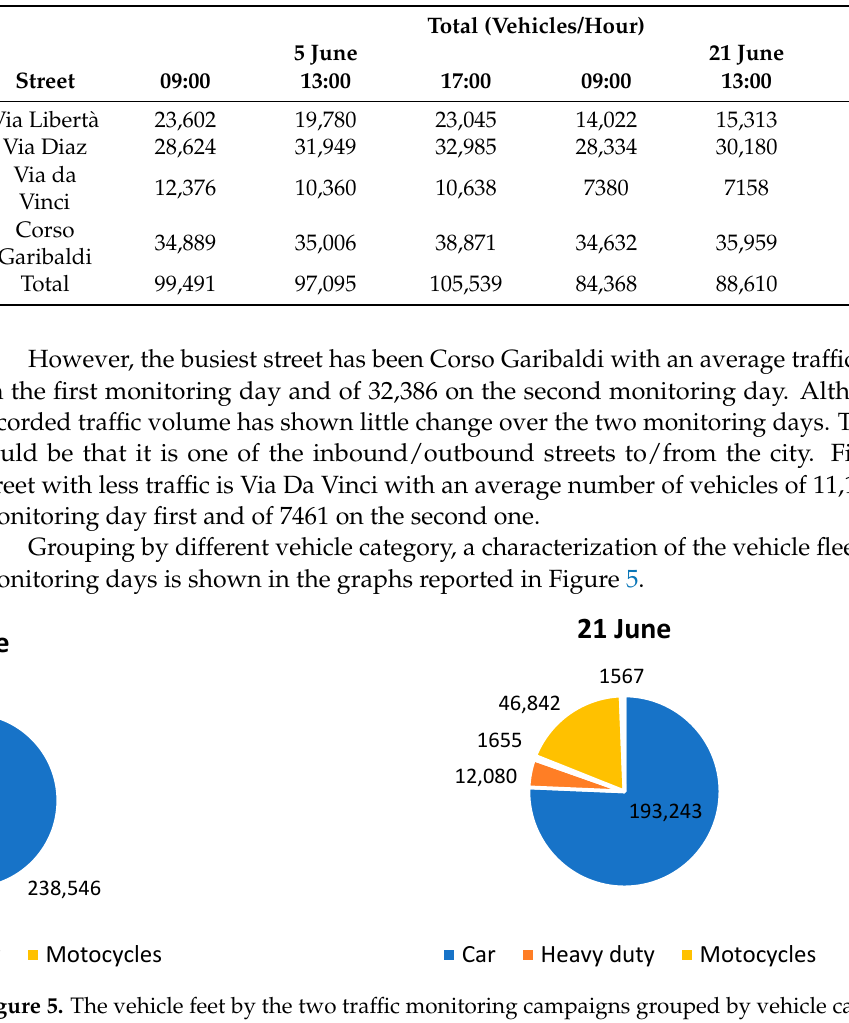
Table 2. Overview of traffic vehicular campaigns.